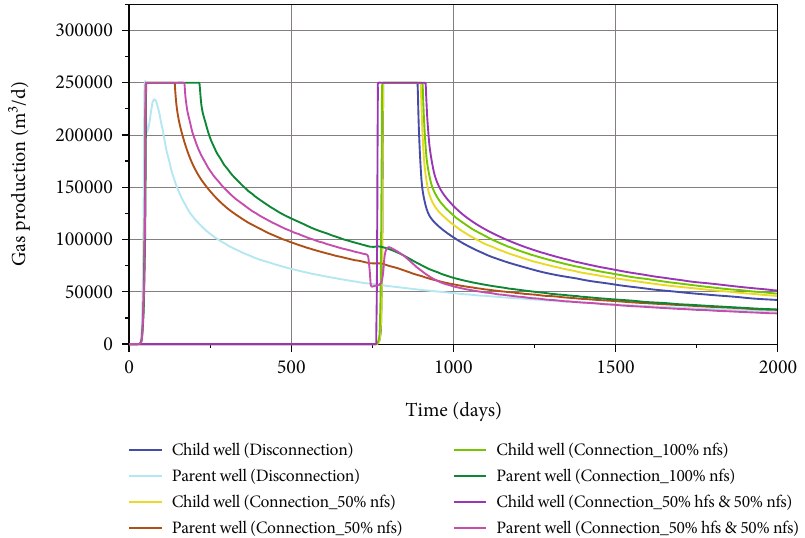
Figure 8: Production curves of two MFHWs considering both hydraulic fractures and natural